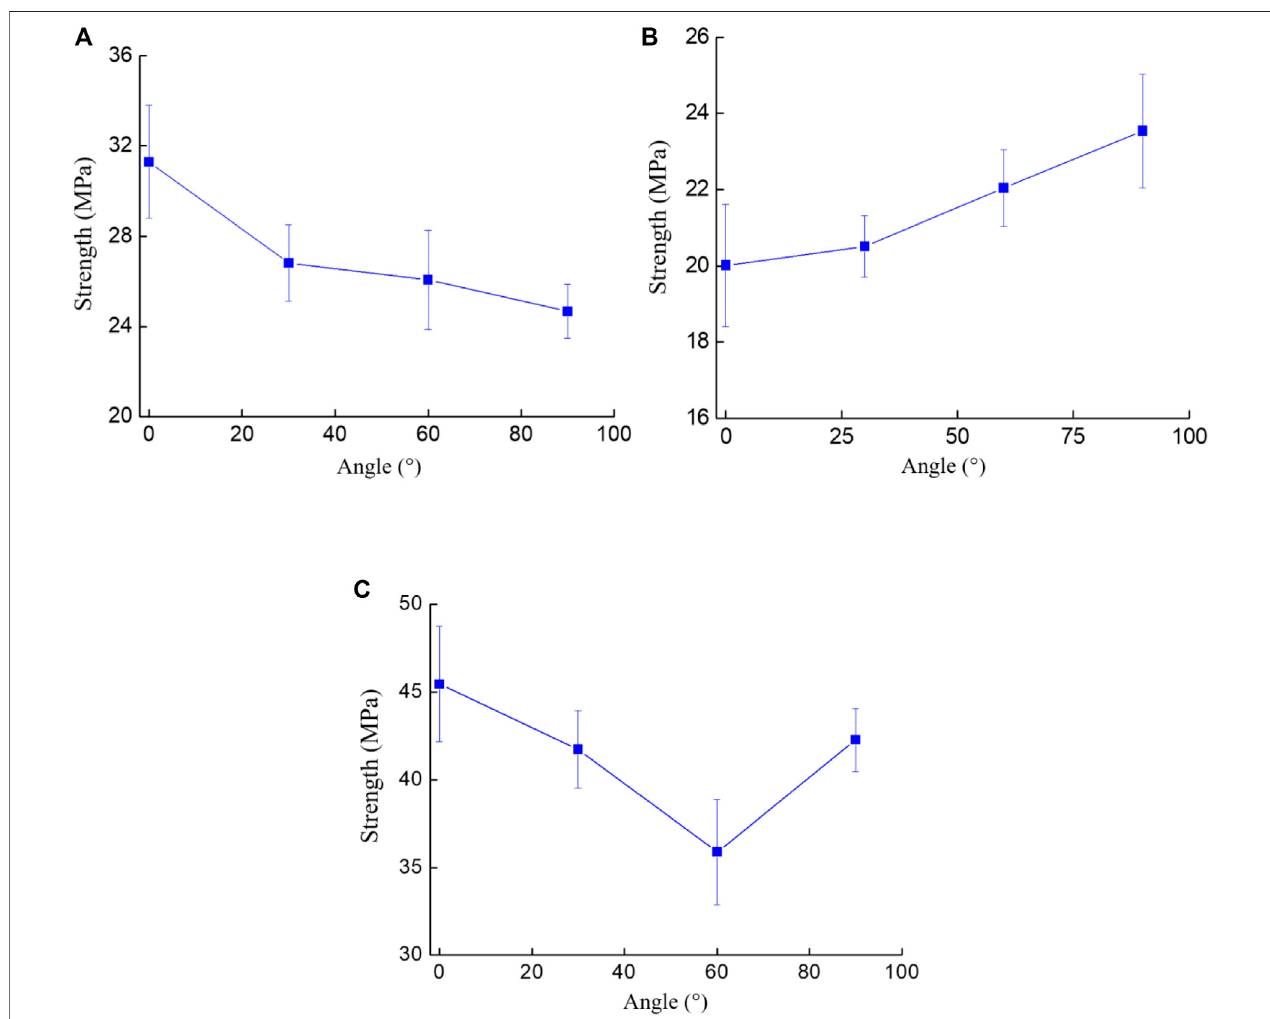
FIGURE 7 | Relationship between the strength of all T-shaped cracked samples and the included angle between major and minor fi ssures. (A) T-shaped cracked sample containing the major fi ssure inclination angle of 0 ° , (B) T-shaped crack sample containing the major fi ssure inclination angle of 45 ° , (C) T-shaped crack sample containing the major fi ssure inclination angle of 90 °